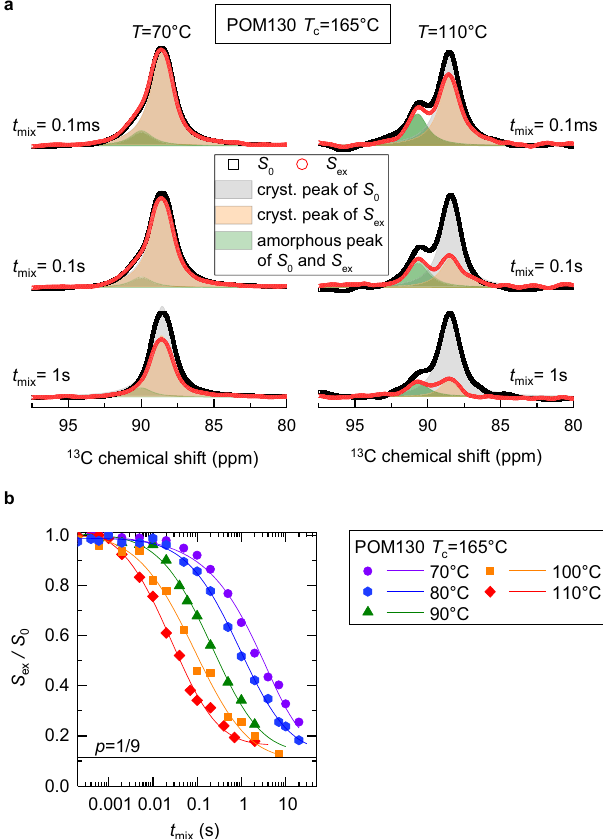
Fig. 6 Exemplary NMR analysis on the POM samples. a 13 C CP MAS spectra of the exchange S ex (red) and reference signal S 0 (black) for three different mixing times at two temperatures. The resonances are deconvoluted into the amorphous (green) and crystalline exchange (orange) and reference (grey) peak. b CODEX t mix decay curves for four different temperatures resulting in the Arrhenius temperature dependence shown in Figure